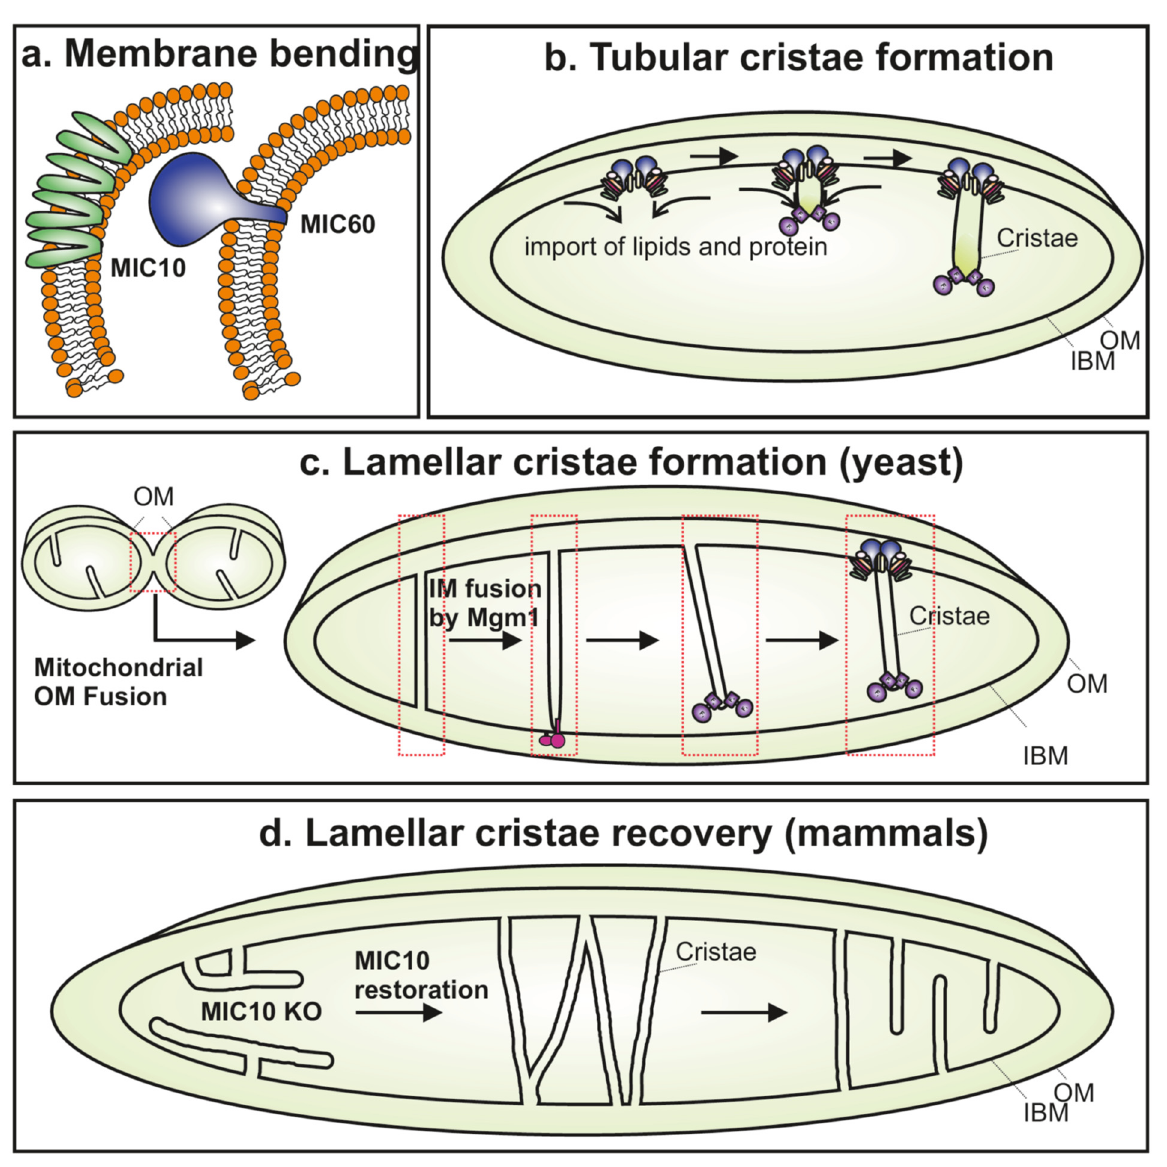
Figure 3. Various roles of the MICOS complex in regulating cristae biogenesis. ( a ) MIC10 and MIC60 can generate membrane curvature by bending the lipid bilayer. Mic10 has a hairpin topology and the oligomerization of Mic10 results in membrane bending. Mic60 contains an amphipathic helix that is known to generate membrane curvature important for membrane bending activity. ( b ) The MICOS complex is shown to initiate the formation of tubular cristae in yeast that involves the influx of lipids and proteins as the primary steps. F 1 F O ATP synthase oligomers at cristae tips/rims are also depicted. ( c ) The lamellar cristae in yeast are proposed to be formed during the process of inner membrane fusion by Mgm-1 (OPA1 homolog). MICOS is required to complete the formation of these lamellar cristae by formation of CJs involving the assembly of the MICOS complex. ( d ) Mammalian MIC10 KO cells contain few tube-like cristae, and the following re-synthesis of MIC10 over time leads to a recovery of lamellar cristae. This is proposed to mainly occur via restructuring of existing unstructured tubes to form lamellar cristae rather than de novo cristae biogenesis.